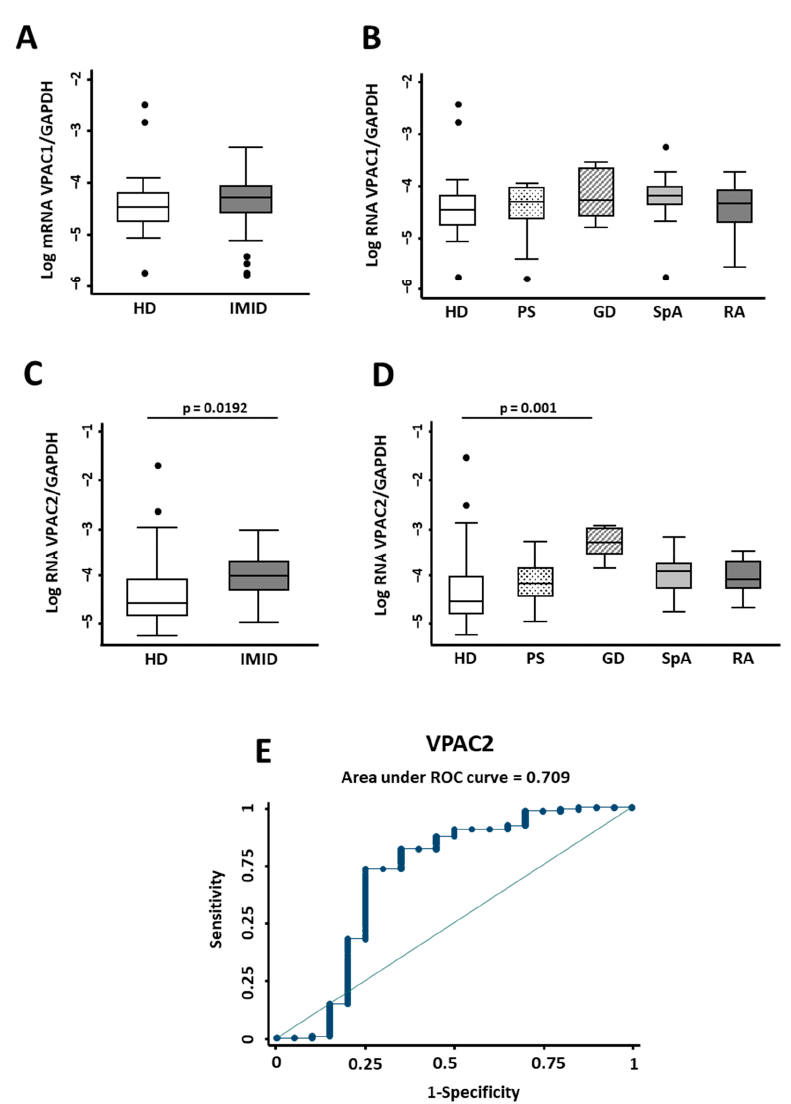
Figure 2. Expression of the VIP/receptor axis in inflammatory/autoimmune pathologies. ( A ) The relative expression of VPAC1 / GAPDH mRNA normalized by log transformation of 38 healthy donors (HD) and 52 patients with immune-mediated inflammatory diseases (IMID) is shown. Statistical significance was determined with Student’s t -test. No significant differences were observed. ( B ) Log of relative expression of VPAC1 / GAPDH mRNA of 38 healthy donors (HD) and 15 patients with psoriasis (PS), 8 with Graves’ disease (GD), 15 with spondyloarthritis (SpA), and 14 with rheumatoid arthritis (RA) is shown. ( C ) Log of relative expression of VPAC2 / GAPDH mRNA of 38 healthy donors (HD) and 52 patients with immune-mediated inflammatory diseases (IMID) is shown. Statistical significance was calculated using relative expression of VPAC2 / GAPDH mRNA normalized by inverse square root using Student’s t -test. The p -value is shown in the figure. ( D ) Log of relative expression of VPAC2 / GAPDH mRNA of 38 healthy donors (HD) and 15 patients with